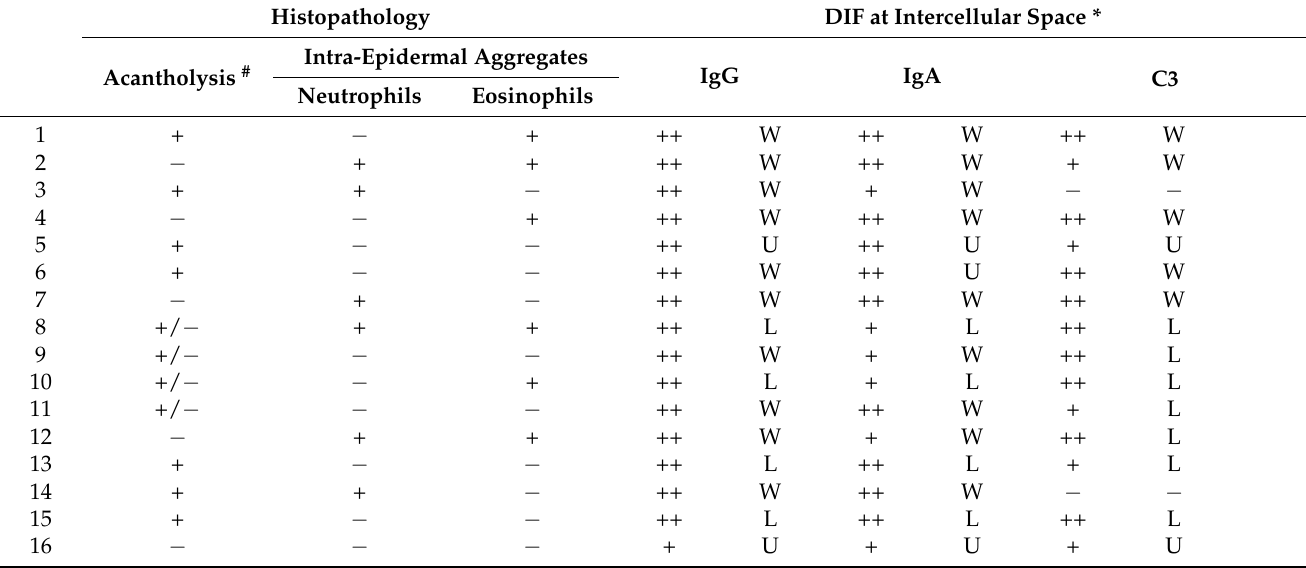
Figure 3. Comparisons of immunohistochemical stains between patients with IgG/IgA pemphigus and those with conventional pemphigus. ( a ) Representative images of stains from two cases of IgG/IgA pemphigus and two cases of conventional pemphigus (Scale bar = 100 µ m). ( b ) Patients with IgG/IgA pemphigus ( N = 22) show significantly higher expression of IL-8 and MMP-9 and lower expression of C5a in the epidermis compared to patients with conventional pemphigus ( N = 20) (*, p < 0.05, ns, non-significance). Table 2. Results of histopathology and direct